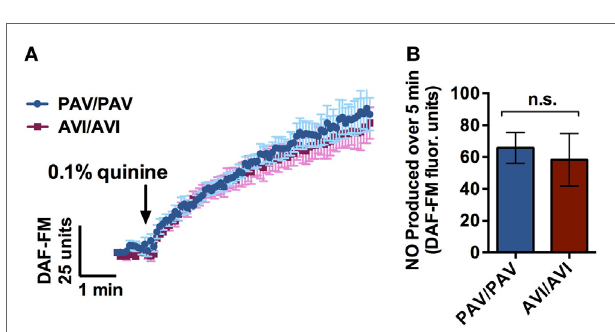
FigUre 3 | 1% Quinine hydrochloride application significantly increases ciliary beat frequency (CBF) in sinonasal air–liquid interface cultures, compared to control saline ( n = 6–7 cultures). Increases are reported in stimulated CBF/baseline CBF. (a) CBF increases over a 15 min period, and (B) a snapshot of CBF change after 10 min. ** p < 0.01.